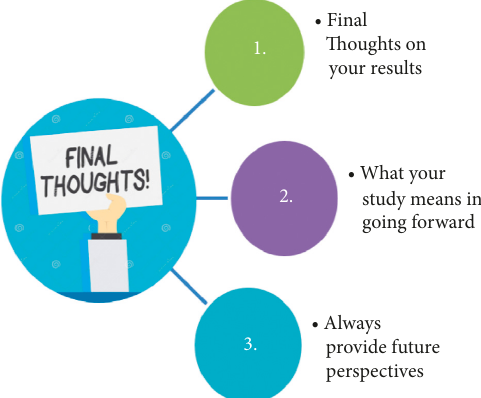
Figure 10: Crux of the conclusion section.